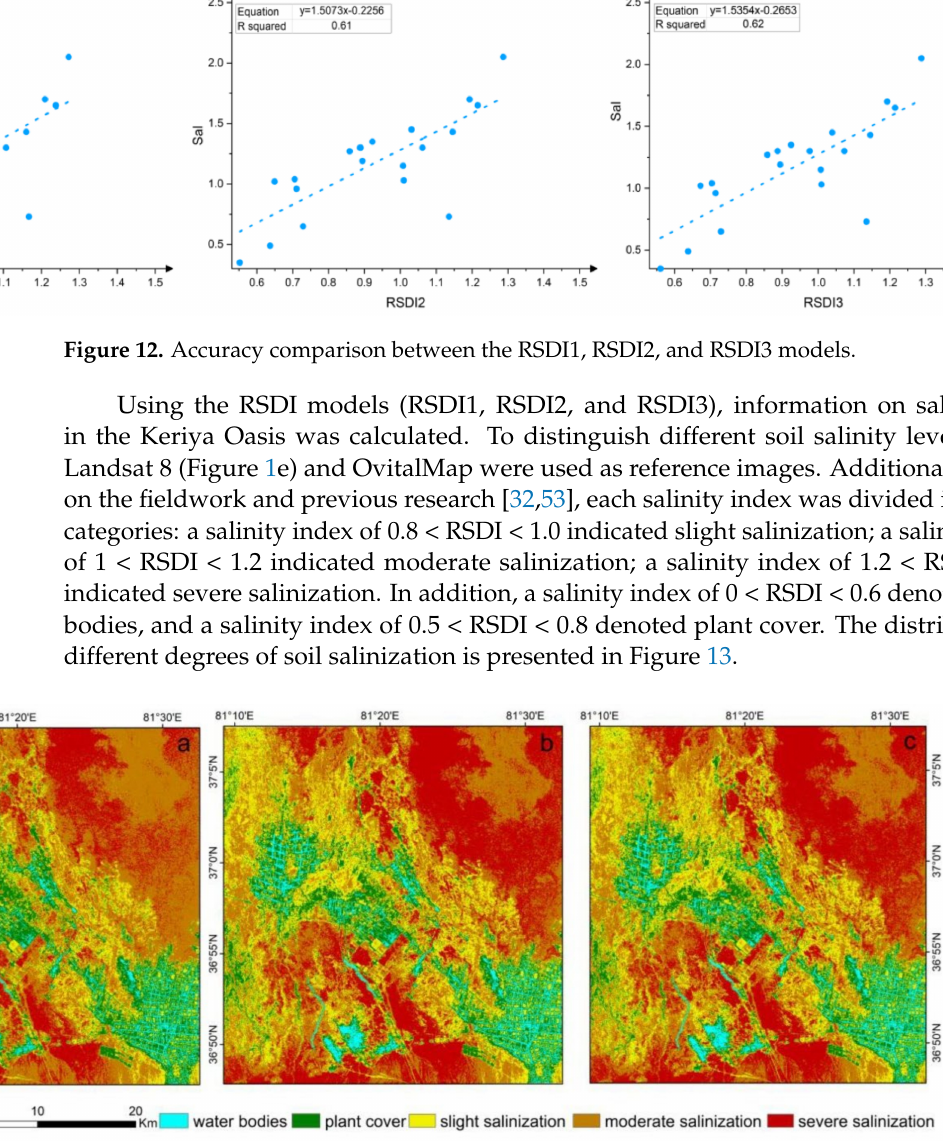
Figure 13. Spatial distribution patterns of different levels of soil salinization ( a ) RSDI1; ( b ) RSDI2; ( c )